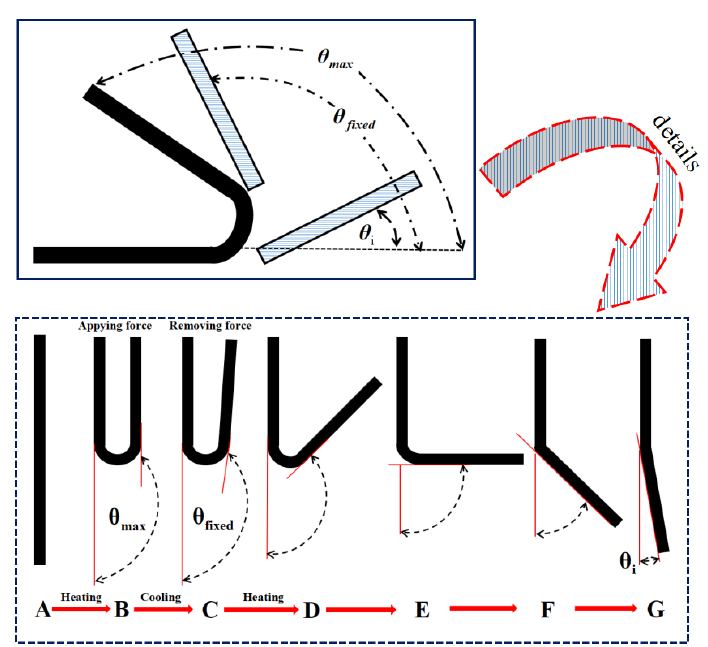
Figure 2. Schematic diagram of the folding deploy shape memory testing.